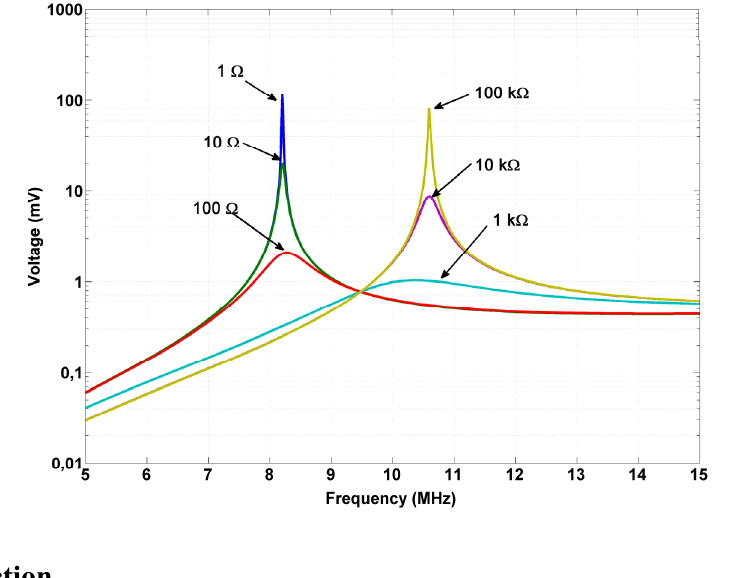
Figure 3. Simulation results showing resonance frequency shift for different resistance values of the sensor.